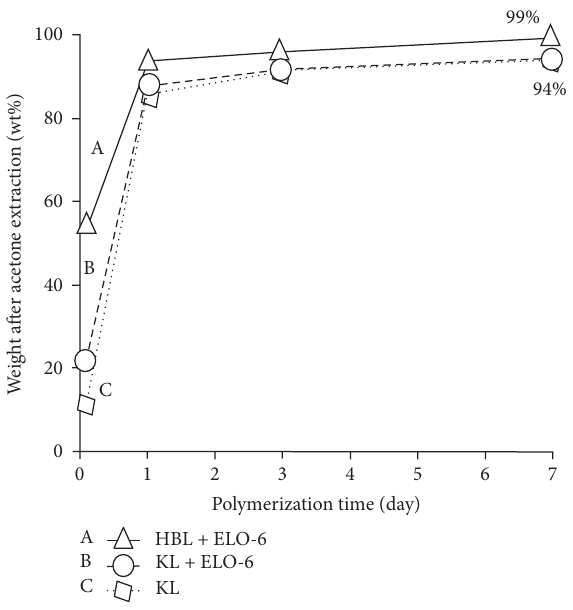
Figure 2: Extraction of polymerized film by acetone. After 7 days of polymerization, the weight of the film of the HBL paint with ELO-6 in the weight proportion of 10: 1 remained at more than 99 wt% after extraction with acetone, suggesting that the HBL paint with ELO-6 was completely